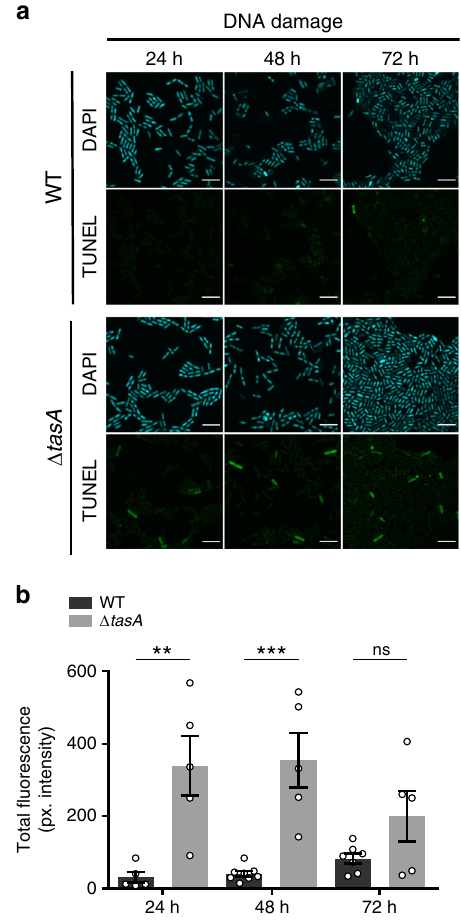
Fig. 5 The Δ tasA cells exhibit higher levels of DNA damage. a CLSM analysis of TUNEL assays revealed signi fi cant DNA damage in the Δ tasA cells (bottom panels) compared to that in the WT cells (top panels). Cells were counterstained with DAPI DNA stain (top images). Scale bars = 5 µ m. Experiments have been repeated at least three times with similar results. b